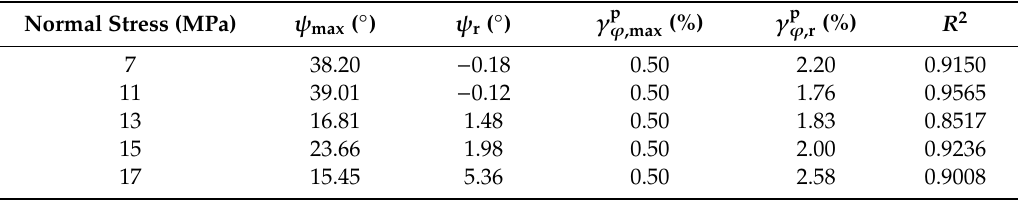
Table 2. Fitted parameters for the dilation angle–plastic shear strain curves under different normal stresses.